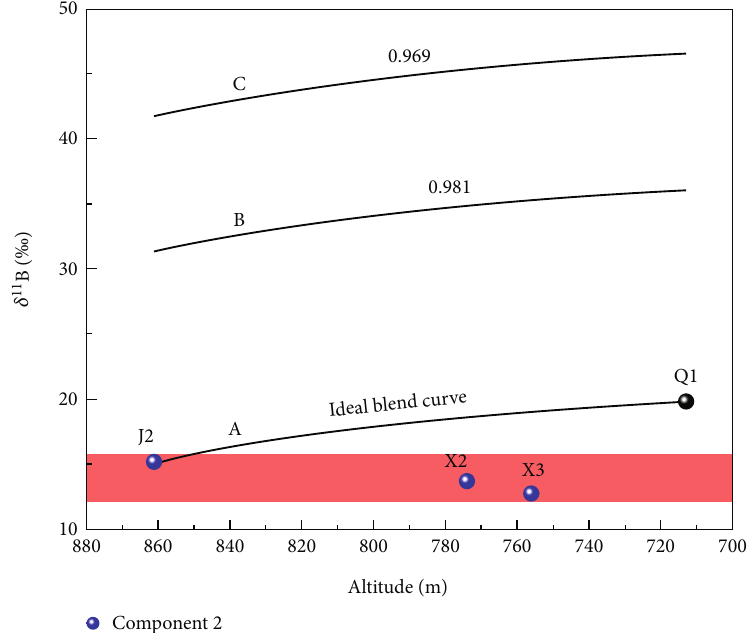
Figure 8: Relationship between the δ 11 B values and the altitude of the samples sampling sites (J1, X2, and X3) and the Uzong spring water samples.